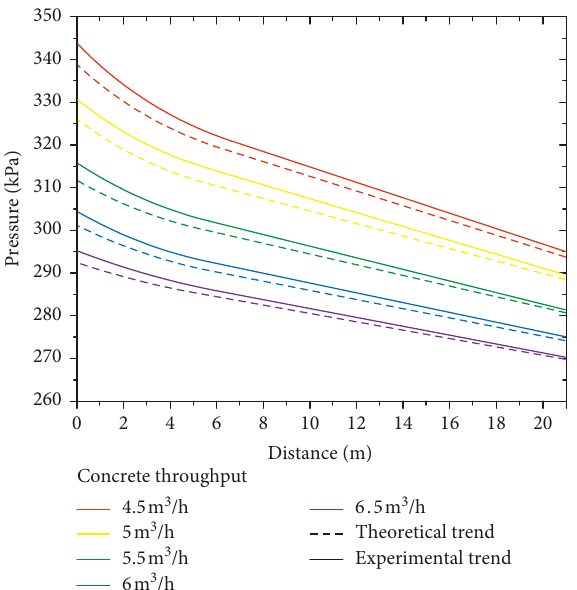
Figure 10: Comparison of theoretical and experimental pressures after adding α .